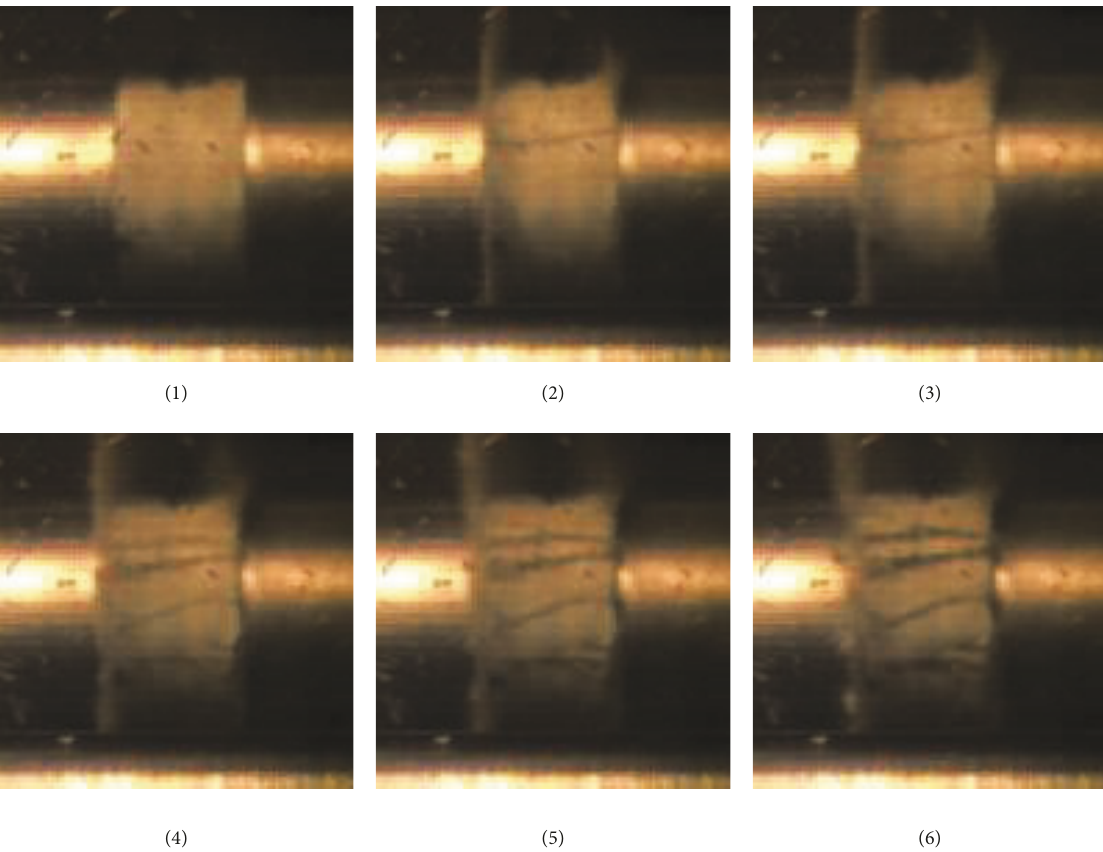
Figure 14: Photograph of fracture process from tests (the length-diameter ratio of specimen is 0.5, and the average strain rate is 119s −1 ).